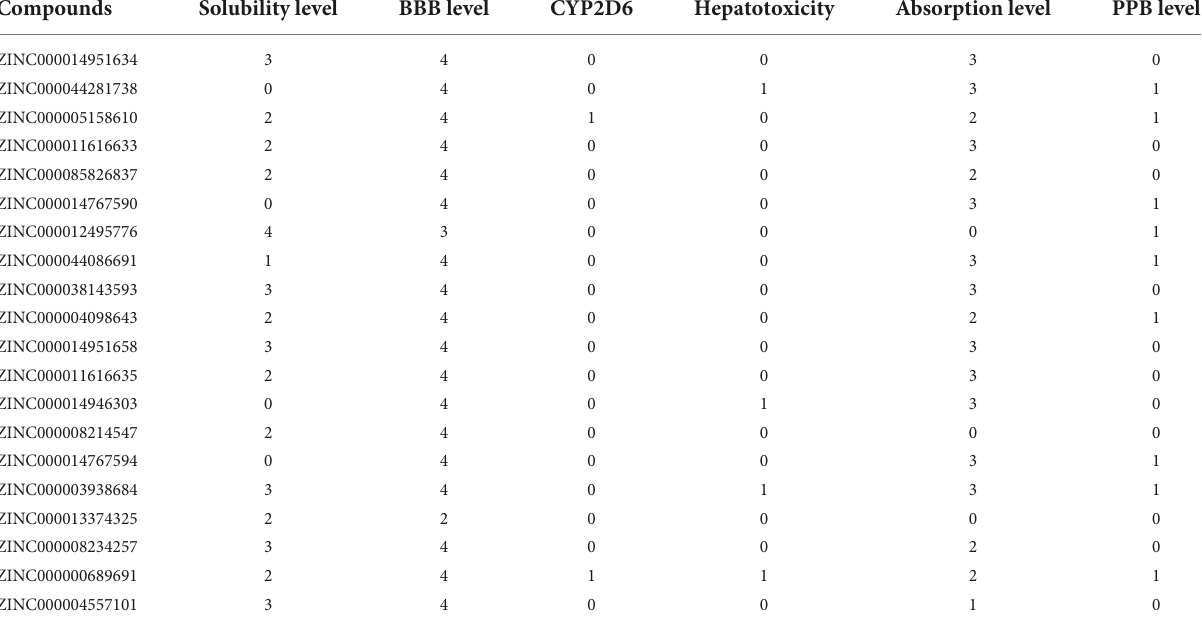
TABLE 3 Adsorption, distribution, metabolism, and excretion properties of compounds.